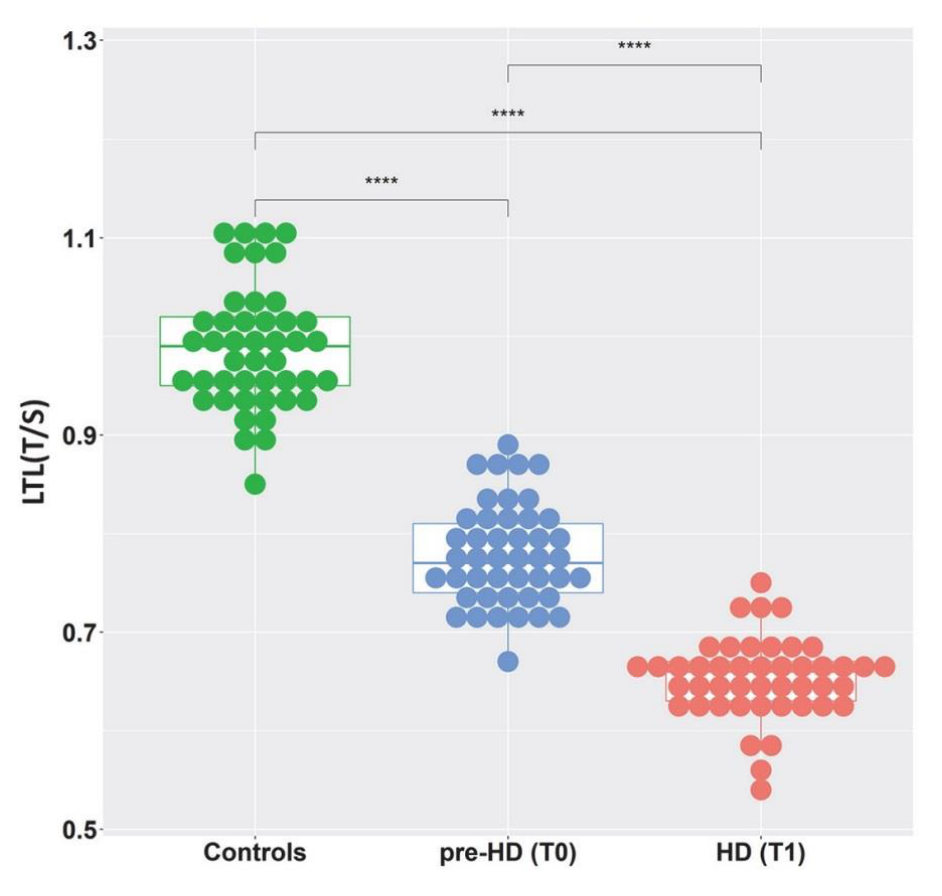
Figure 1. Distribution of LTL in controls, pre-HD, and HD patients. Box plot showing the distribution of LTL expressed as a relative telomere length T/S ratio (the number of copies of telomeric repeats T compared to a single-copy gene S) used as a quantitative control. LTL measures are presented for control subjects (green) and for patients in the pre-HD stage (blue) and the following corresponding HD stage (red). (**** = p <